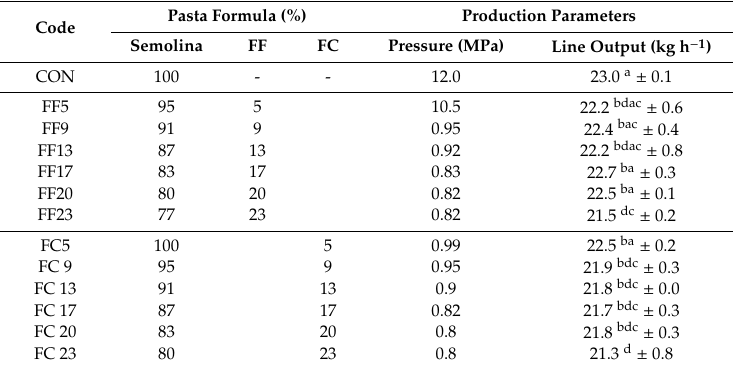
Table 1. Model of experiment and production